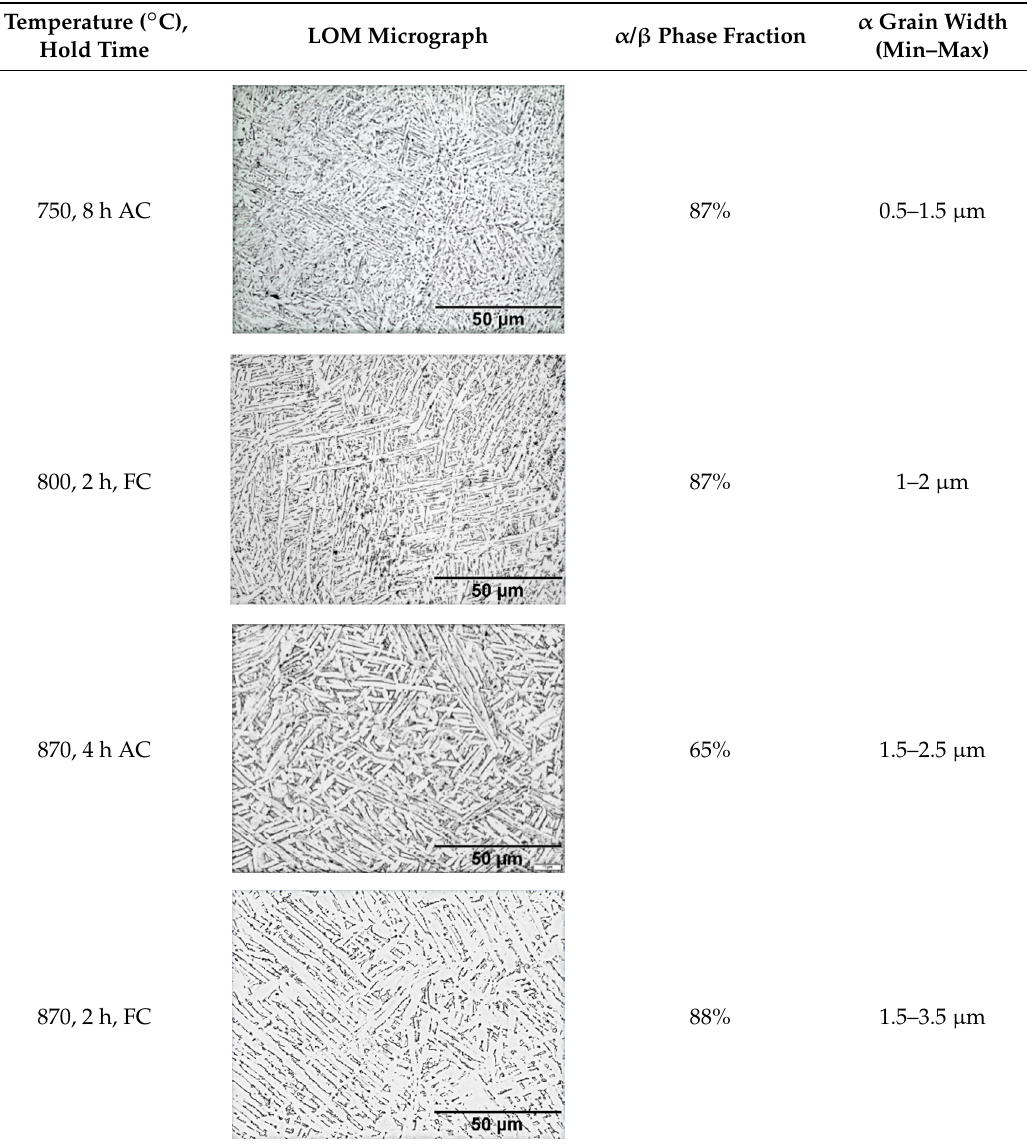
Table 5. Microstructure summary—low and medium-SSTR annealing.